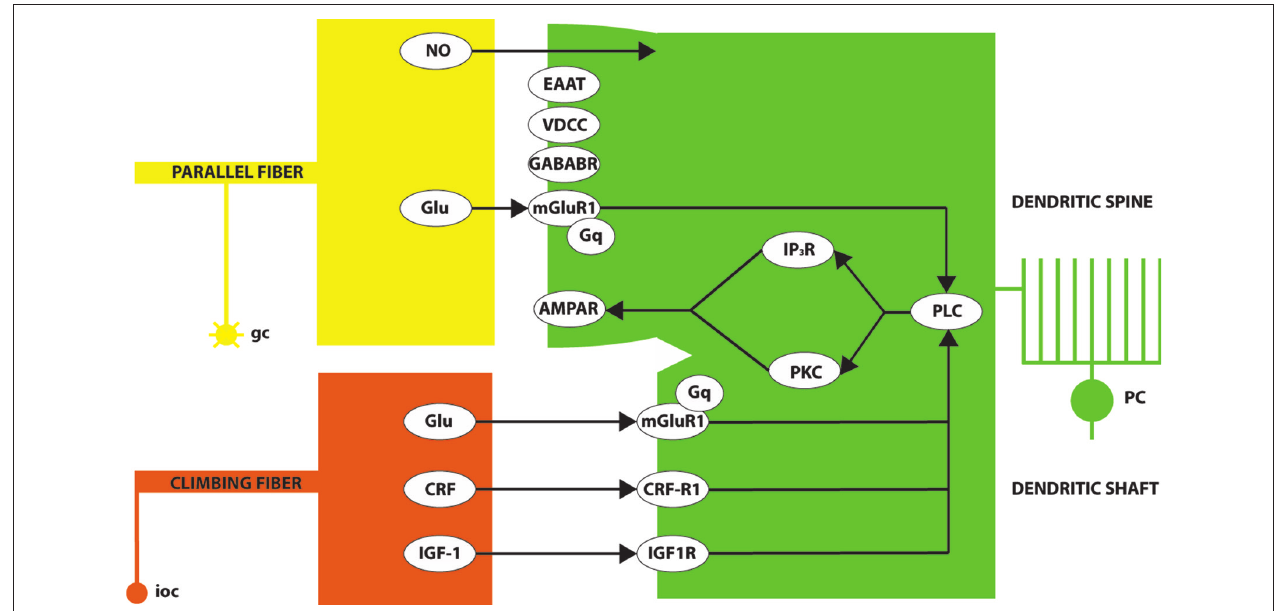
inositol triphosphate receptor (IP 3 R) and protein kinase C (PKC). The upshot is the internalization of synaptic AMPA receptors and consequent LTD. The overall process is also modulated by various other signals including: presynaptic nitric oxide release (NO); the binding of corticotropin-releasing factor (CRF) to its receptor (CRF-R1) and insulin-like growth factor (IGF)-1 binding to its receptor (IGF-1R), both of which signal via PLC; signaling via postsynaptic GABA B R; and calcium influx through voltage-dependent calcium channels